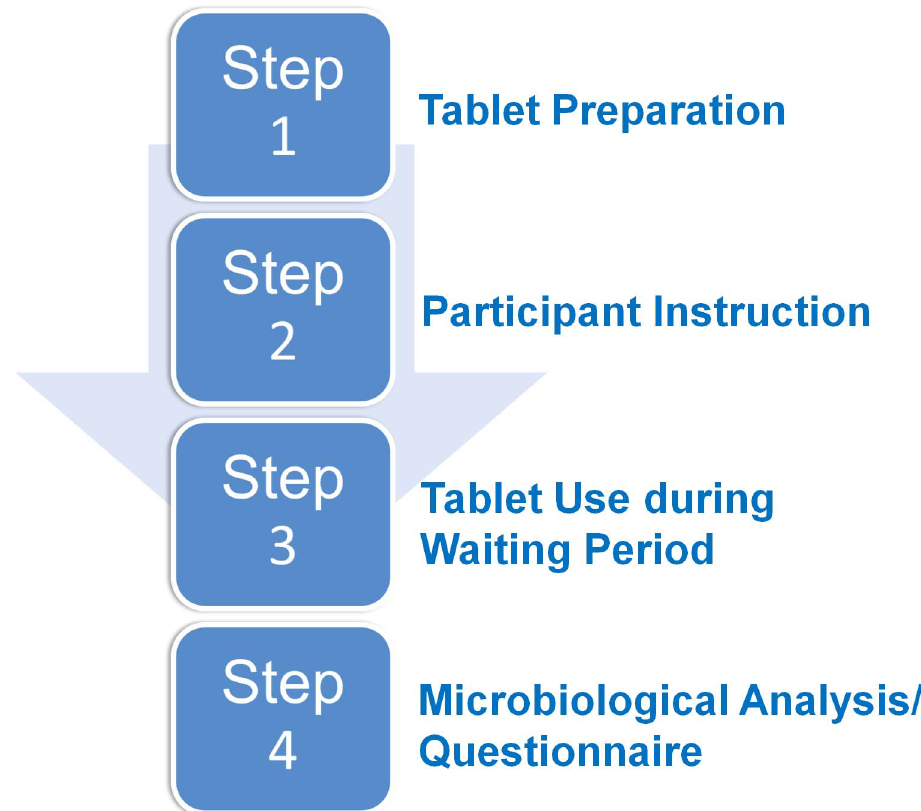
Figure 1. Successive steps of the procedure.